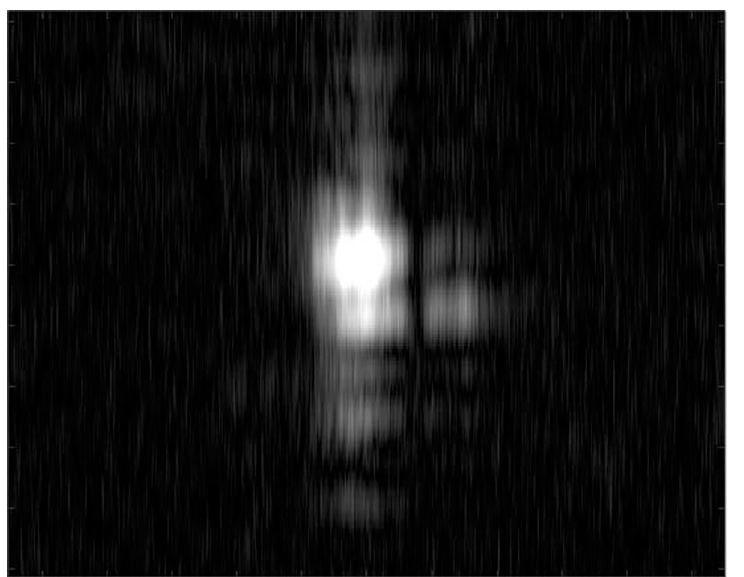
Fig 15. The real focused results.